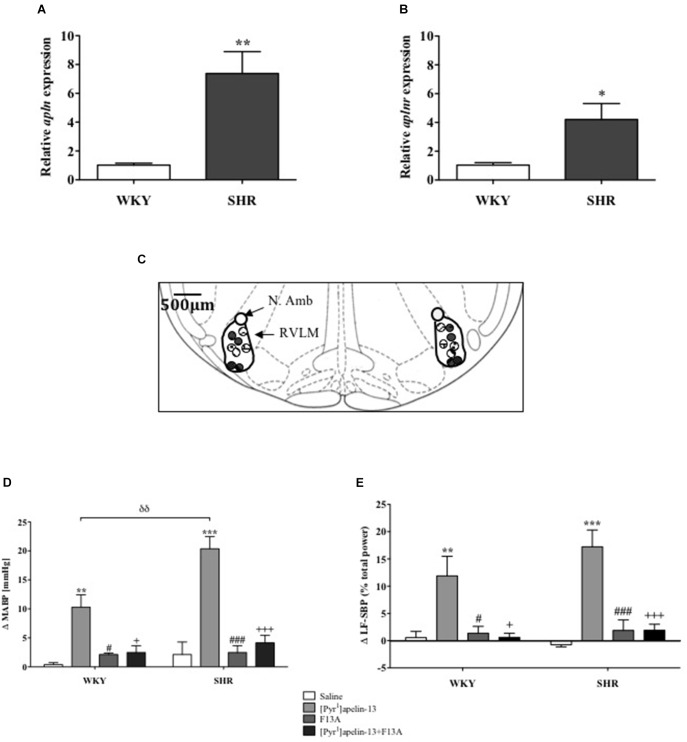
The apelinergic system is upregulated in SHR. Relative expression of (A)
apln and (B)
aplnr in RVLM micropunches from WKY (n = 4) and SHR (n = 4) rats quantified by RT-PCR. Data shown is mean ± SEM. ∗P < 0.05, ∗∗P < 0.01. (C) Schematic illustrating the localisation of injection sites (matching dots indicate bilateral injection sites), representative of sections from each animal group, determined by examination of the deposition of dye in the brain stem of animals. RVLM and N. Ambiguus (N. Amb) are indicated (Adapted from Paxinos and Watson, 1998; Figure 68). (D,E), change in (D) MABP and (E) LF-SBP following microinjection of saline, [Pyr1]apelin-13, F13A and F13A + [Pyr1]apelin-13 to the RVLM of WKY (n = 4) and SHR (n = 4) rats. Data shown is mean ± SEM. ∗∗P < 0.01, ∗∗∗P < 0.001, saline vs. [Pyr1]apelin-13; #P < 0.05, ###P < 0.001, F13A vs. [Pyr1]apelin-13; + P < 0.05, + + + P < 0.001, [Pyr1]apelin-13 vs. F13A + [Pyr1]apelin-13; δδ
P < 0.01, WKY [Pyr1]apelin-13 vs. SHR [Pyr1]apelin-13.